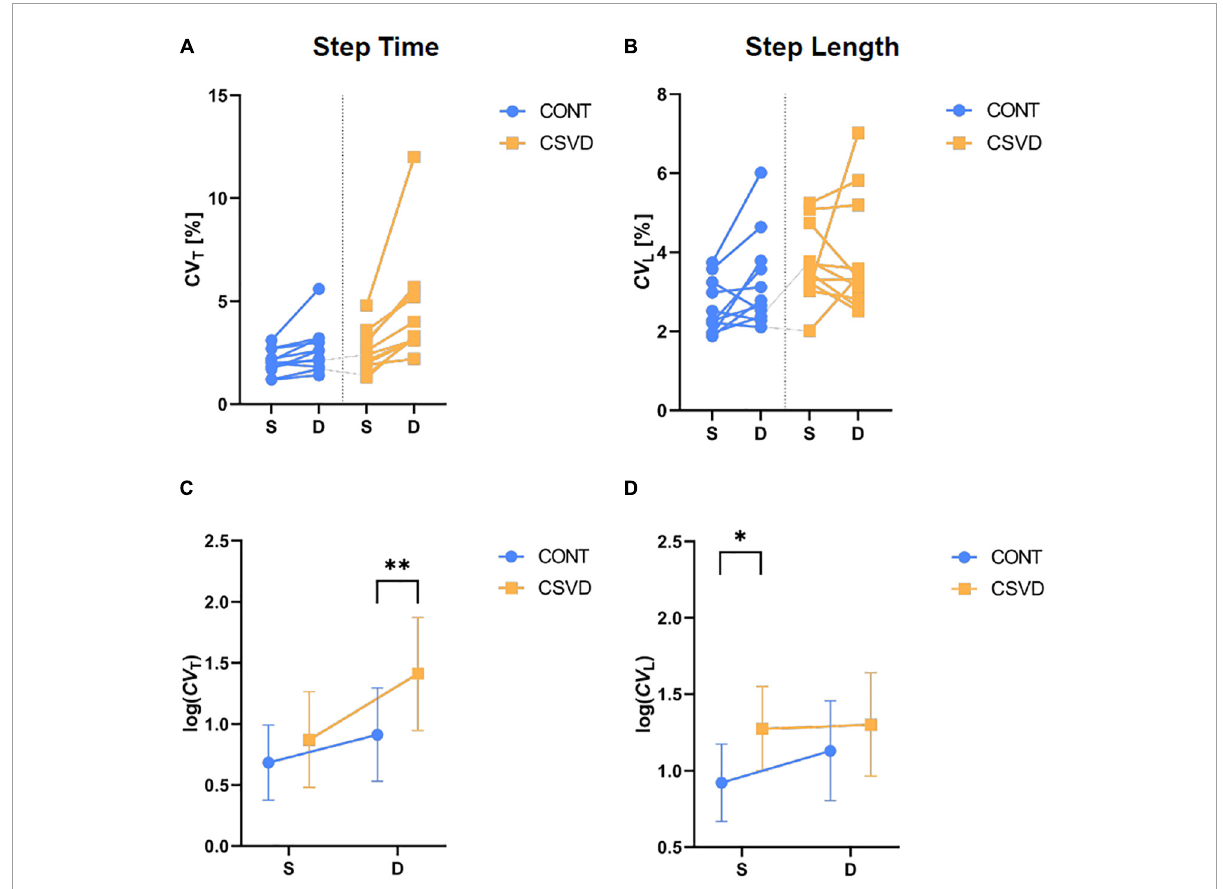
FIGURE2 Alterations in gait variability among older adults with cerebral small vessel diseases (CSVD) during single (S) and dual (D) task conditions. The impact of task condition on Coefficient of Variation (CV) of Step Time [ CV T , panel (A) ] and Step Length [ CV L , panel (B) ] are shown for CSVD ( n = 11; orange square symbols) and age- and sex-matched control (CONT, n = 11; light blue circle symbols) groups, respectively. (C) Log-transformed CV T significantly differs between CONT and CSVD group for dual task condition (two-way RM-ANOVA, p = 0.006; Šidák’s multiple comparisons test, p = 0.009). (D) Log-transformed CV L significantly differs between CONT and CSVD group (two-way RM-ANOVA, p = 0.006) for single task conditions (Šidák’s multiple comparisons test, p = 0.017). Symbol and error bar depict mean ± SD. * p < 0.05, ** p <